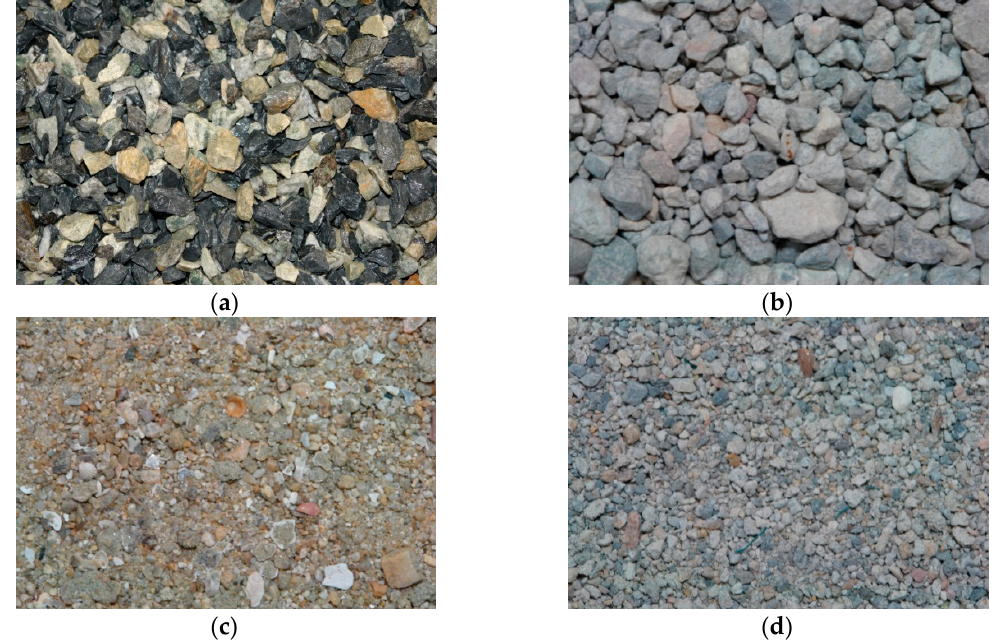
Figure 2. Aggregate used in this study. ( a ) Natural coarse aggregate (NCA); ( b ) RCA; ( c ) Natural fine aggregate (NFA); ( d ) RFA.